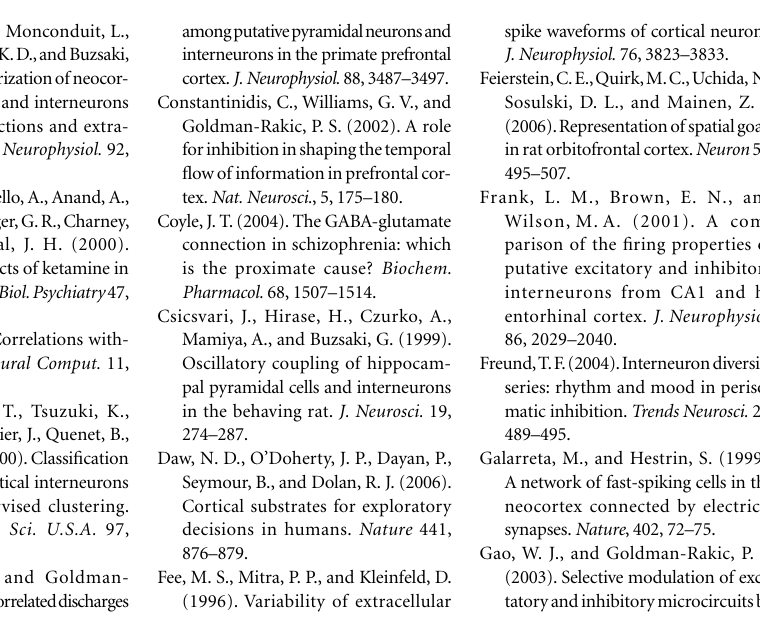
expected to be associated with optimal behavioral functionality, with too low levels of interneuron leading to symptoms associated with hyperarousal (e.g., mania, positive symptoms) and too high levels leading to symptoms of hypoarousal (e.g. depression, negative